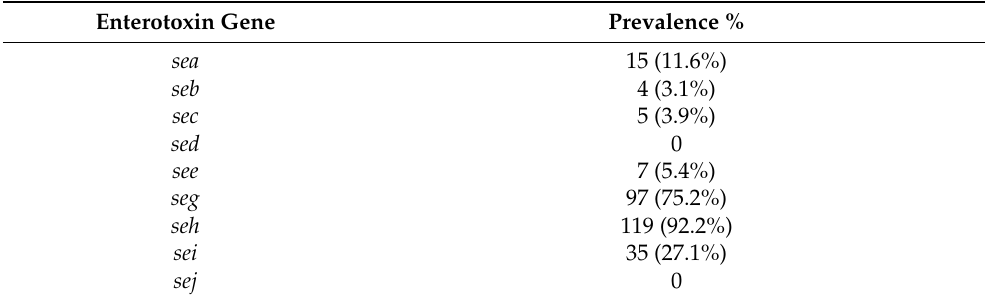
Table 3. Distribution of enterotoxin genes among 129 Staphylococcus aureus isolates positive for at least one